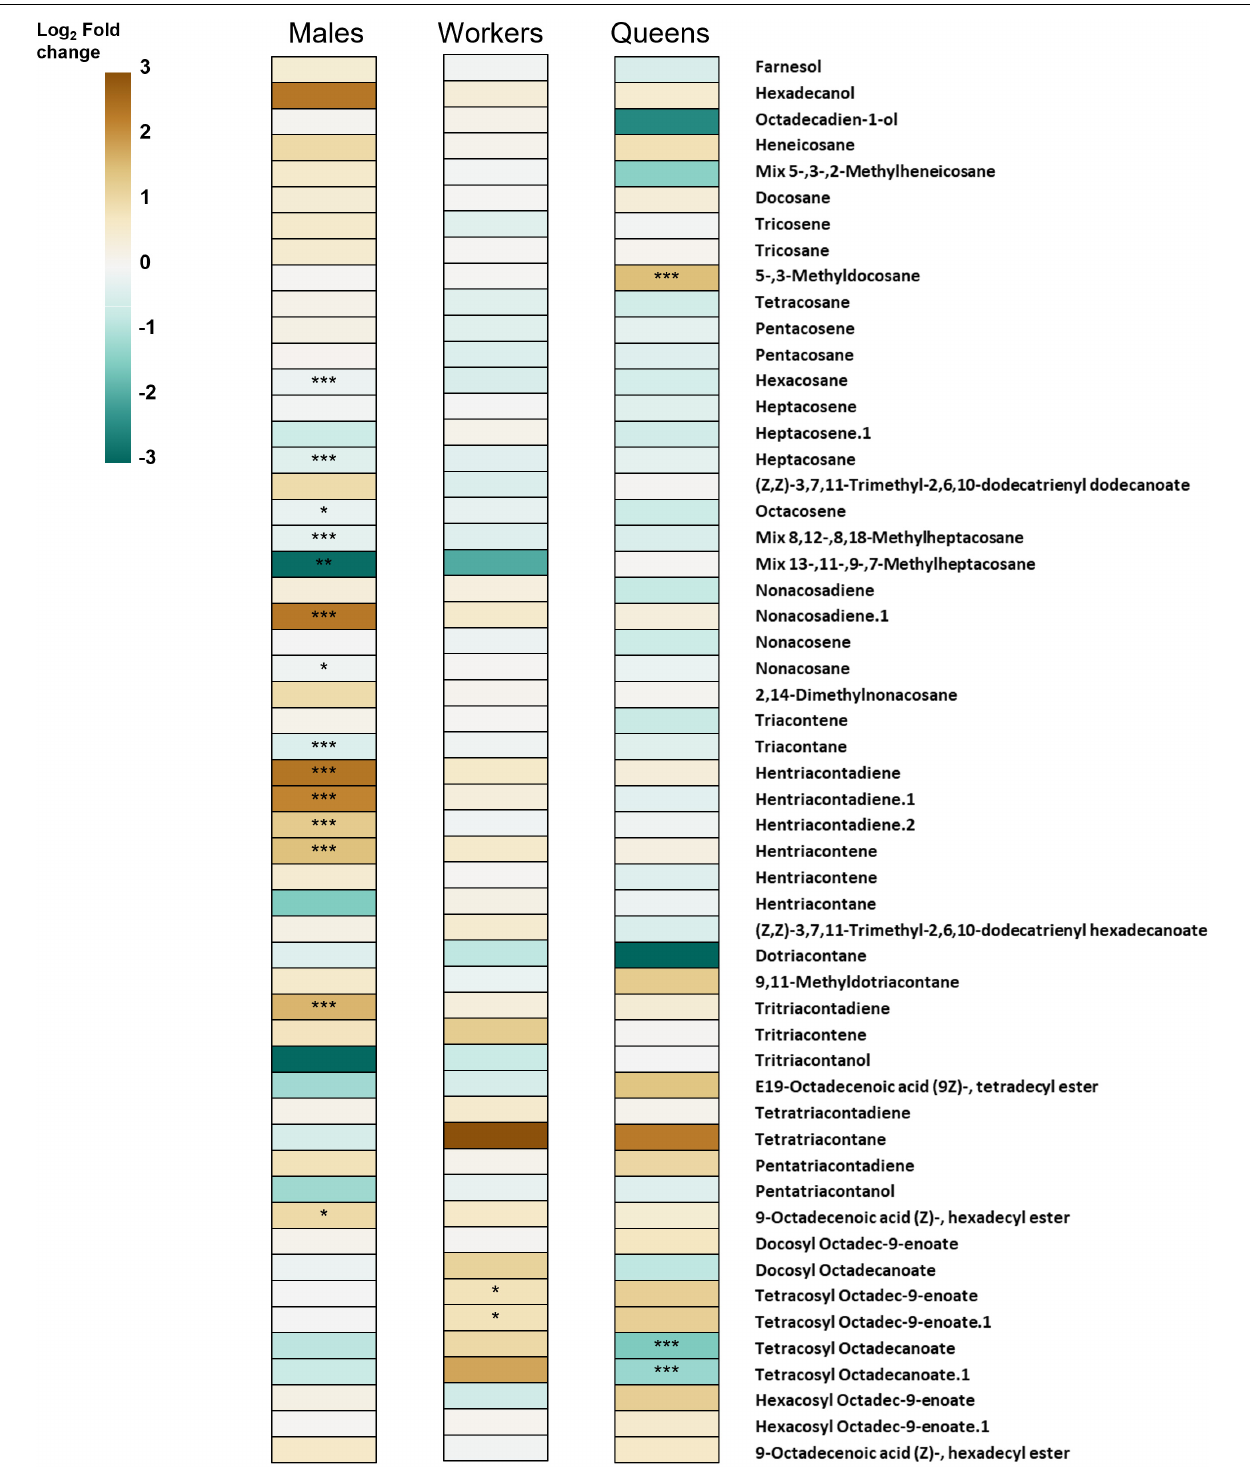
FIGURE 3 | Heatmap with differences in the expression of individual CHCs in males, workers and queens between the two colony phenotypes. The results are presented in terms of the log 2 fold change between the relative abundance of a given compound between late switchers and early switchers. Compounds with colors in the shades of green (between 0 and –3) are more abundant in early switching colonies while compounds with colors in the shade of brown (between 0 and 3) are overrepresented in late switching colonies. Stars indicate significance levels after Bonferroni correction for multiple comparisons: * p < 0.05; ** p < 0.01; and *** p < 0.001. A complete table with chemical compounds, 95% CI intervals and significance levels is shown in Supplementary Table 4 .